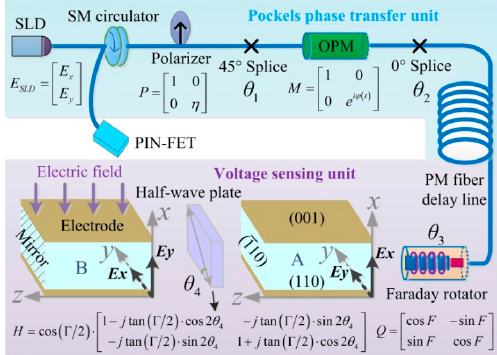
Figure 1. The working principle of the proposed OVS.